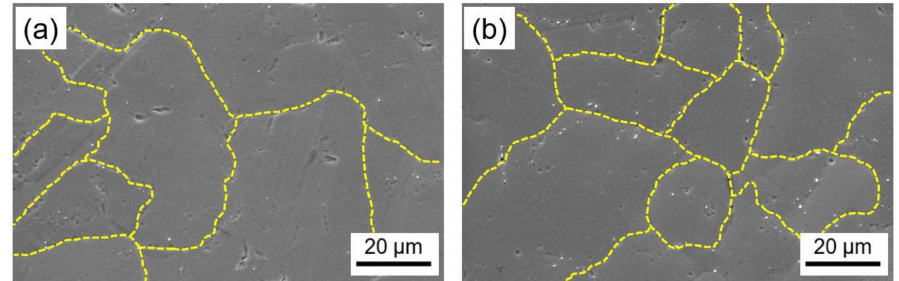
Figure 12. SEM image of ( a ) 4AH and ( b ) 1DAH samples of micro-LPBF